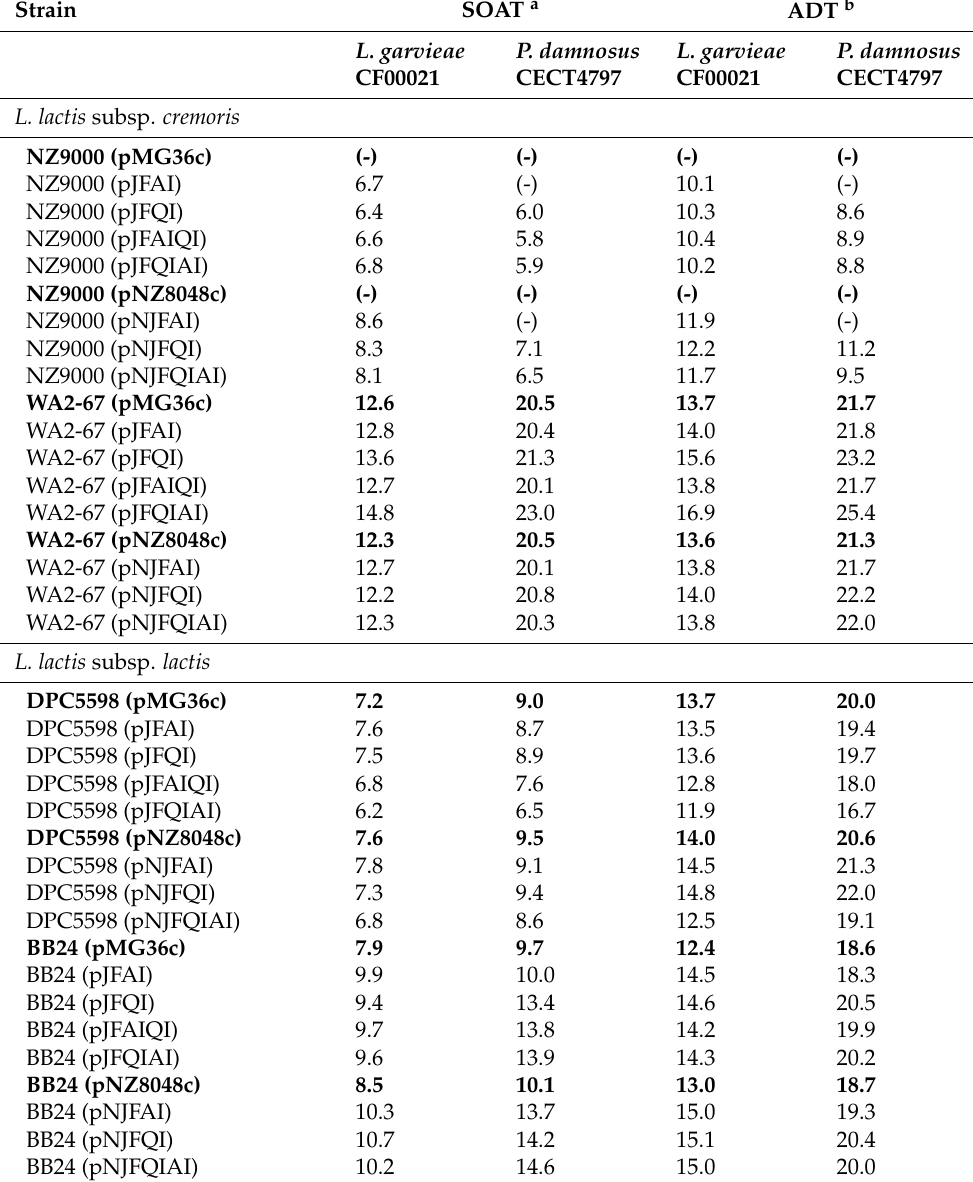
Table 2. Direct antimicrobial activity and extracellular antimicrobial activity of recombinant L. lactis strains, producing garvicin A (GarA) and/or garvicin Q (GarQ), against different bacterial indicators. Strain SOAT a ADT b